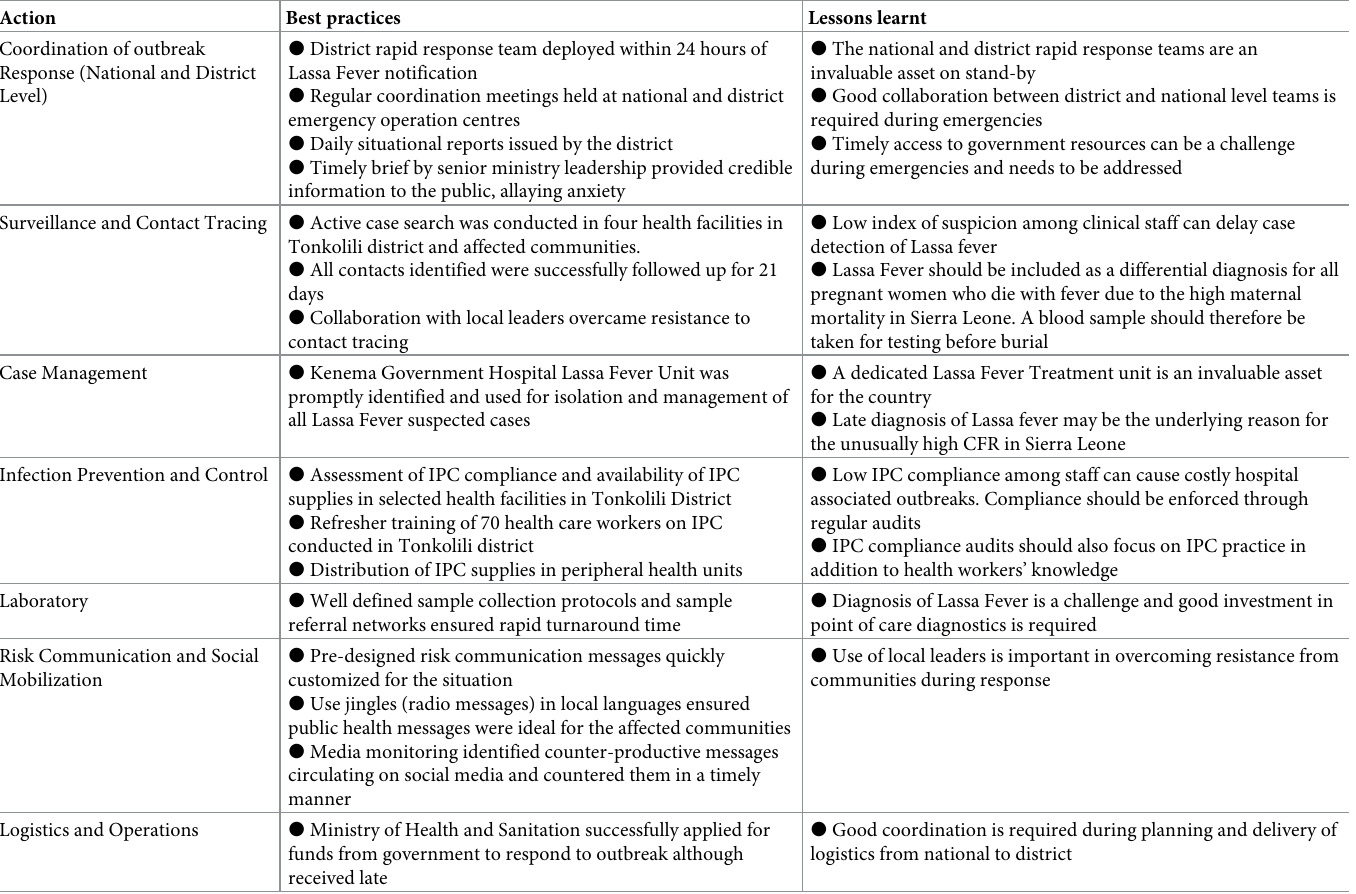
Table 3. Best practices and lessons learnt during Lassa fever outbreak response, Tonkolili district, Sierra Leone, 2019.